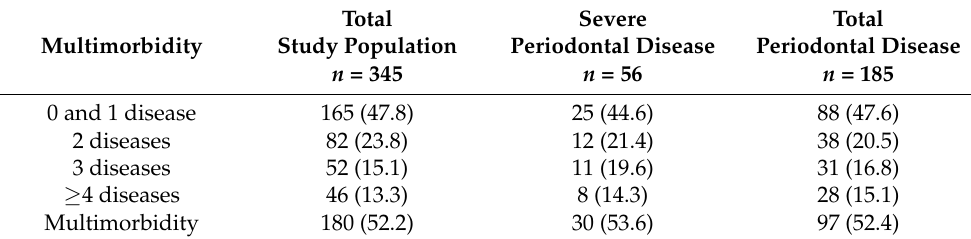
Table 3. Prevalence of multimorbidity in the total study population.